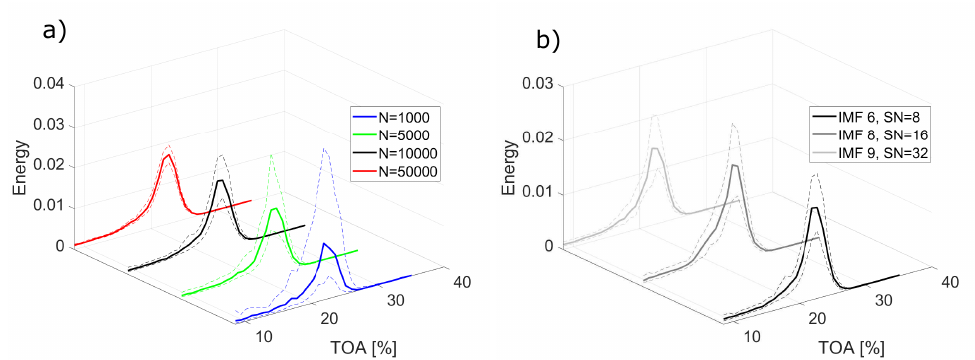
Figure 5. Mean energy E (solid lines) and confidence interval (dashed lines) for different method parameters: ( a ) varying signal length N for SN = 8; ( b ) varying number of siftings for N = 10,000.